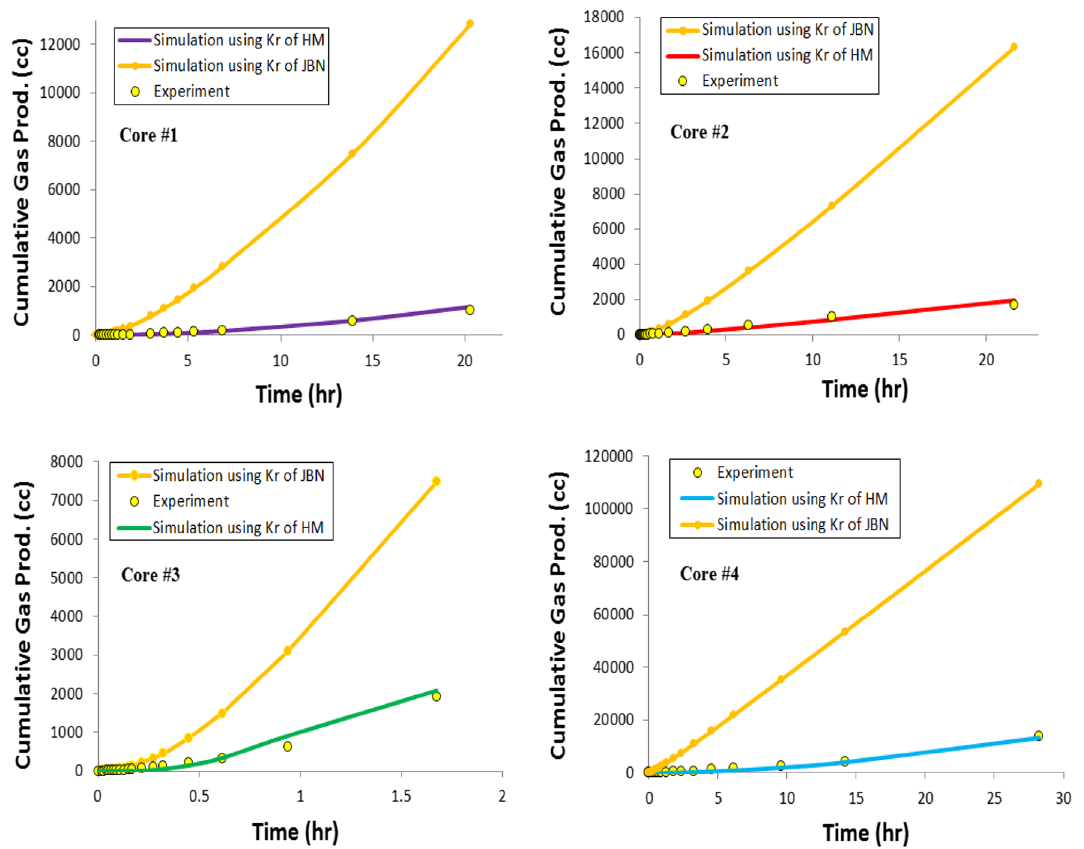
Fig. 9 Experimental results of cumulative gas production compared to the simulation results using k